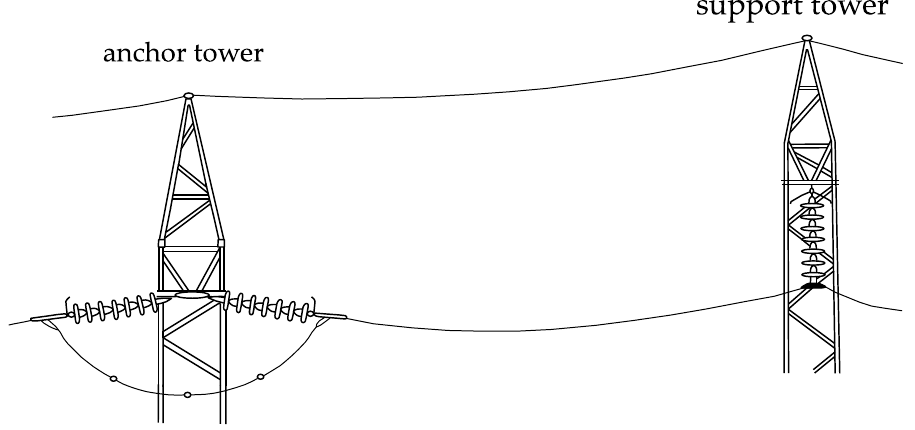
Figure 14. Conductor anchorage on the anchor and support tower.